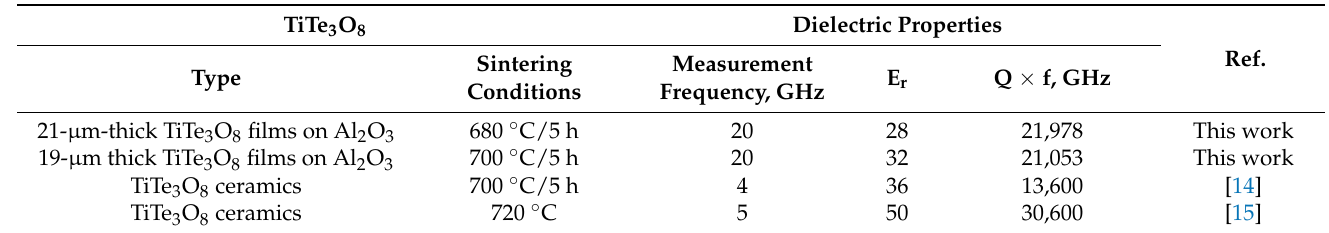
Table 1. Relative dielectric permittivity, quality factor–frequency product and losses of TiTe 3 O 8 thick films and ceramics. Sintering conditions are also